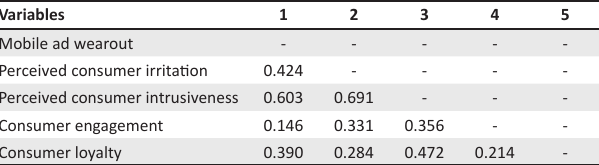
TABLE 4: Divergent validity using heterotrait–monotrait index. Variables